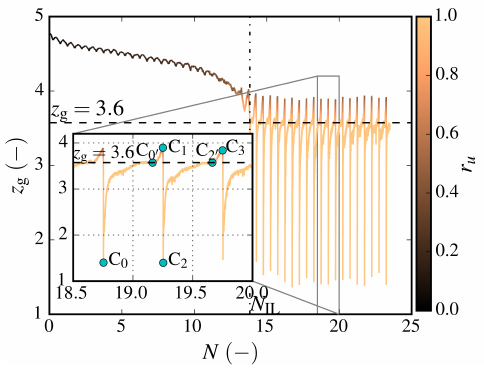
Figure 3: Evolution of coordination number z g during cyclic